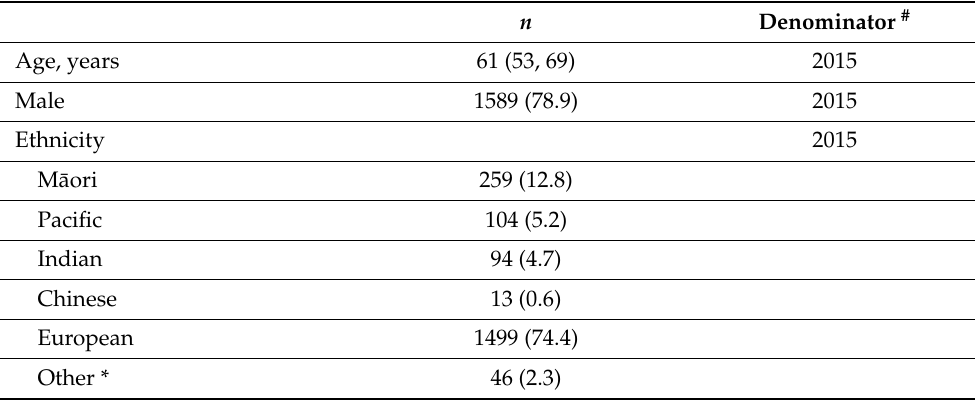
Table 1. Baseline demographics of the MENZACS